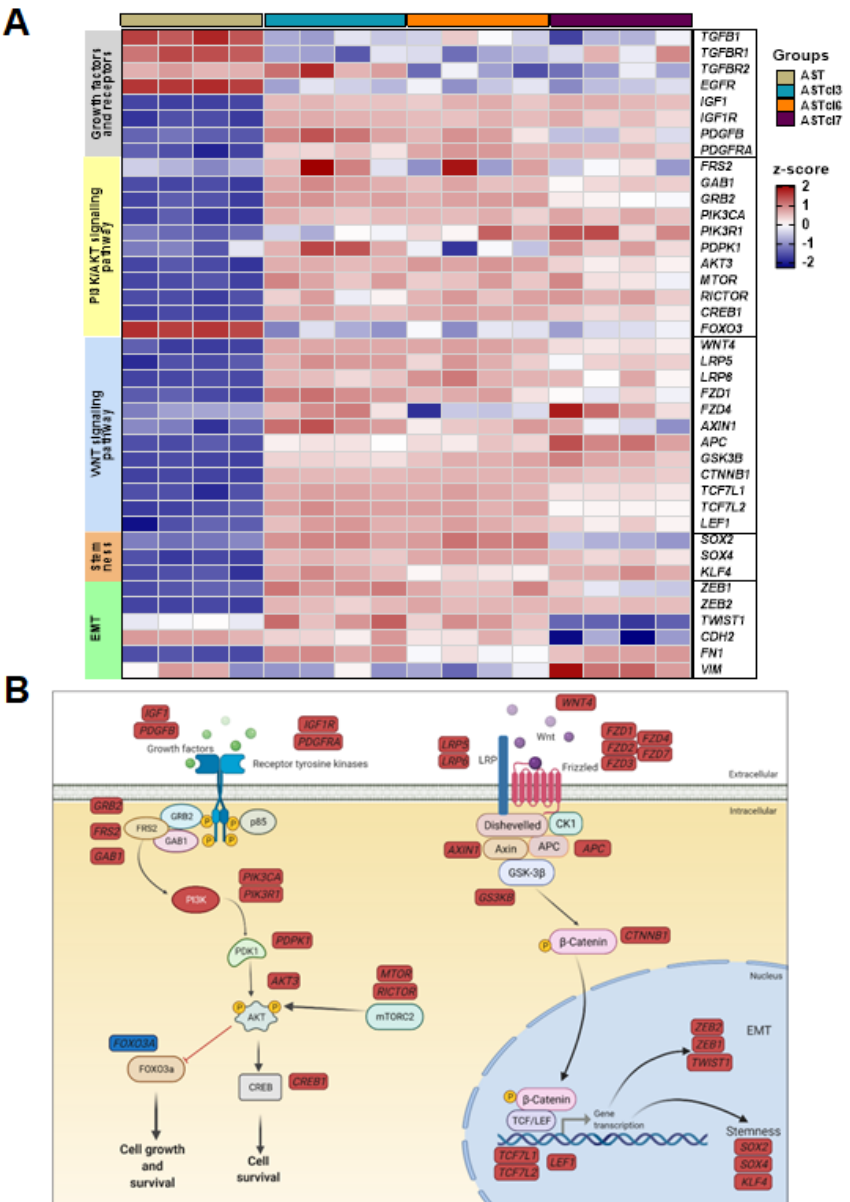
Figure 6. Transcriptome analysis of astrocyte-derived cells: ( A ) Heatmap representing the expression of growth factors and receptors, PI3K/AKT and Wnt signaling pathways, and stemness and EMT genes from RNA-Seq data of primary astrocytes (AST) and derived clones (ASTcl3, ASTcl6, and ASTcl7). ( B ) The PI3K/AKT and Wnt/ β -catenin signaling pathways and the differentially expressed genes (upregulated and downregulated in clones in relation to astrocytes in red and blue, respectively) represented in the heatmap. Activation of these pathways contributed to cell growth and survival and epithelial–mesenchymal transition (EMT), along with the stemness state of astrocyte-derived clones by anoikis resistance. Figure created with BioRender.